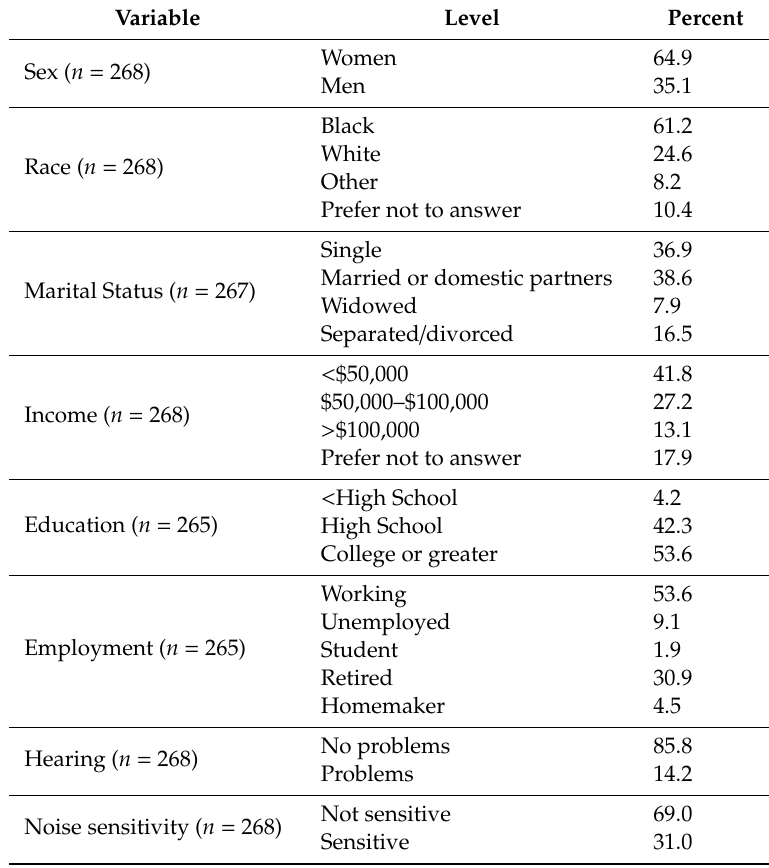
Table 1. Demographic characteristics of survey respondents ( N = 268) for whom complete data were available for regression analysis. Respondents could provide multiple answers for